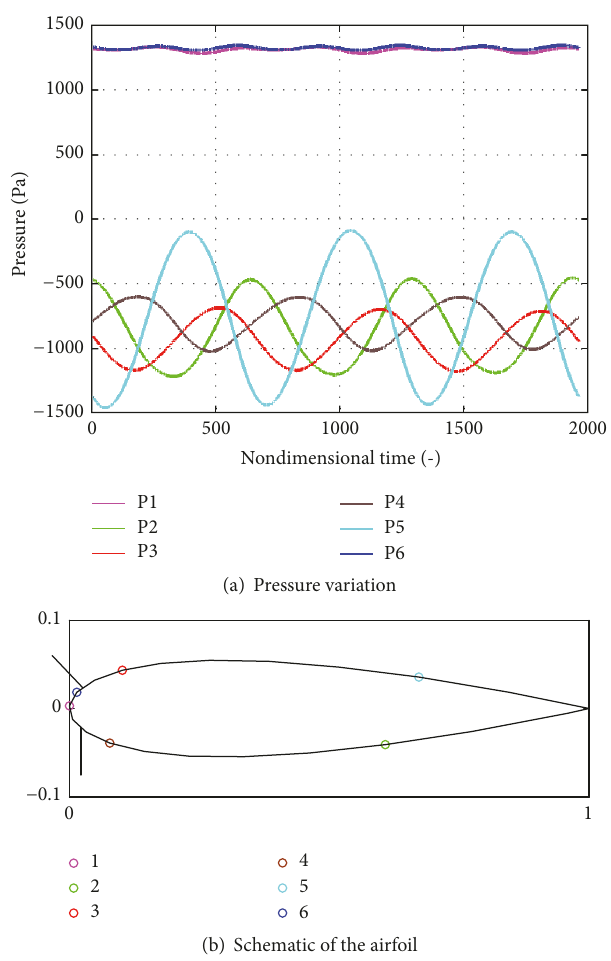
Figure 7: Instantaneous pressure variation of points on the pressure and suctions